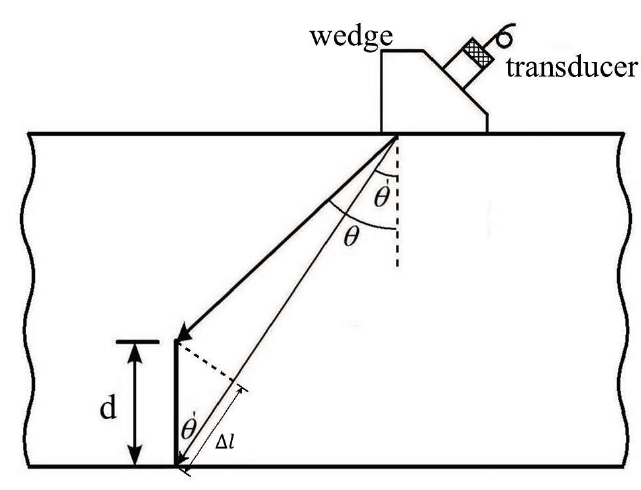
Figure 1. Experimental setup of the ultrasonic testing.